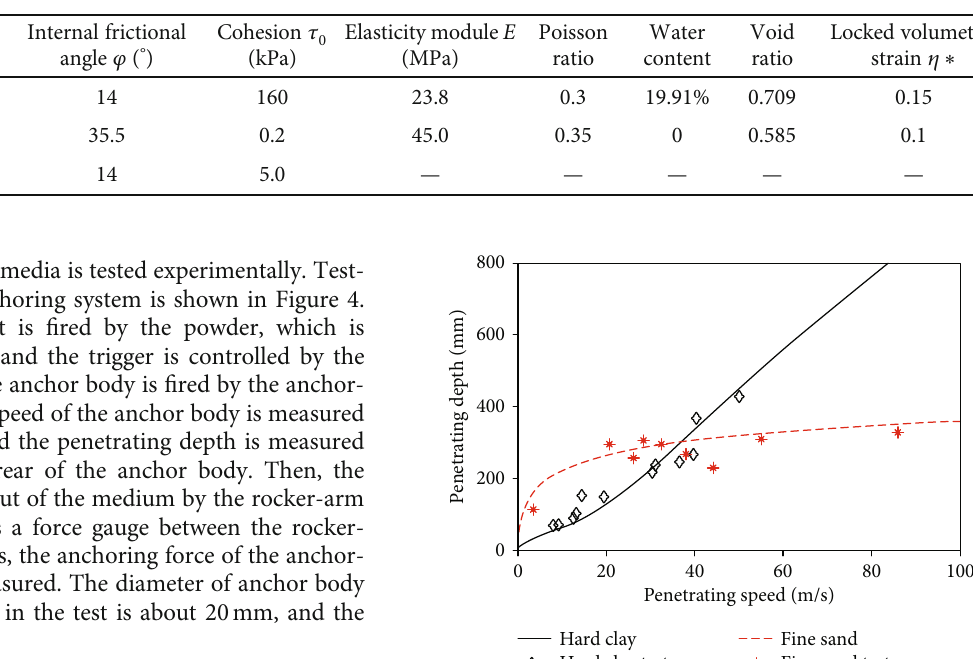
Figure 4: Testing platform of the anchoring system. Table 1: Parameters of the clay and fi ne sand.